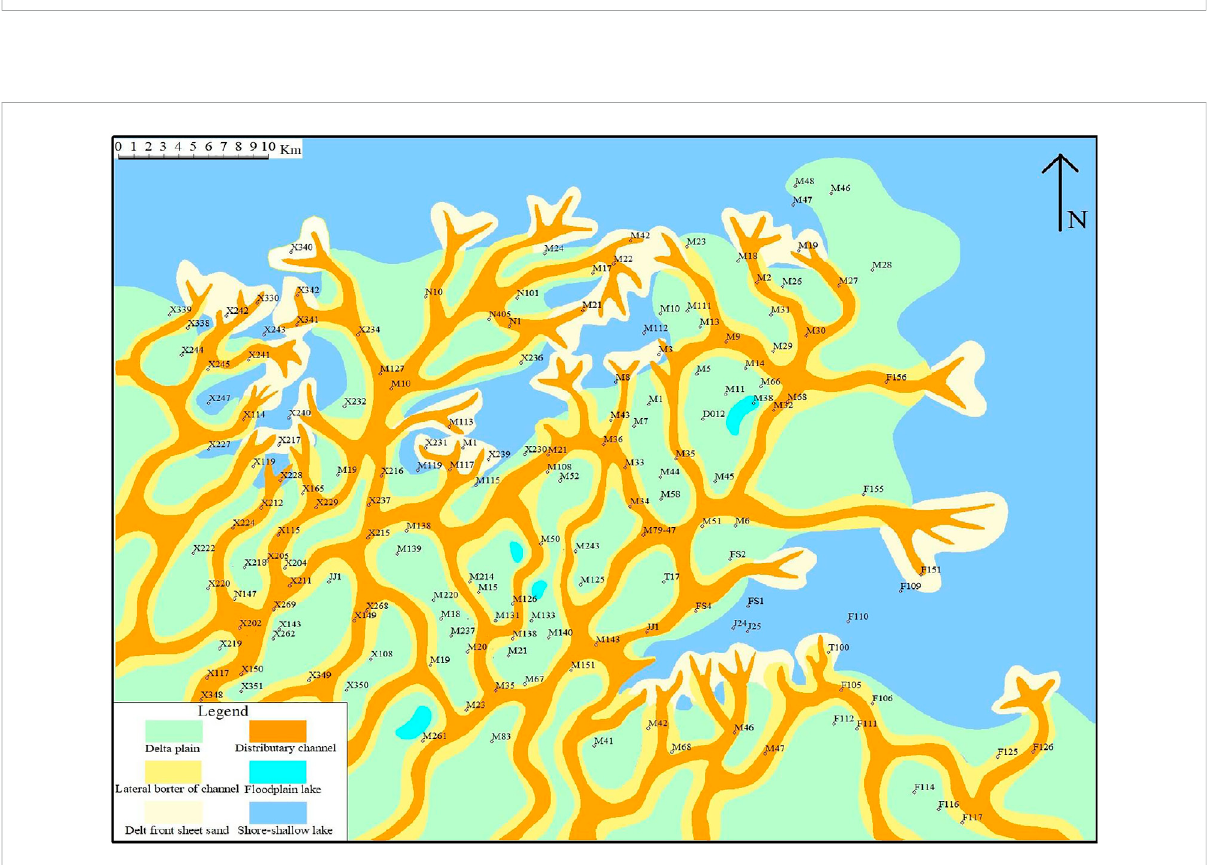
FIGURE 3 Distribution of sedimentary facies of the I sandstone group of the Quan 3 Member in the Fuxin Uplift.